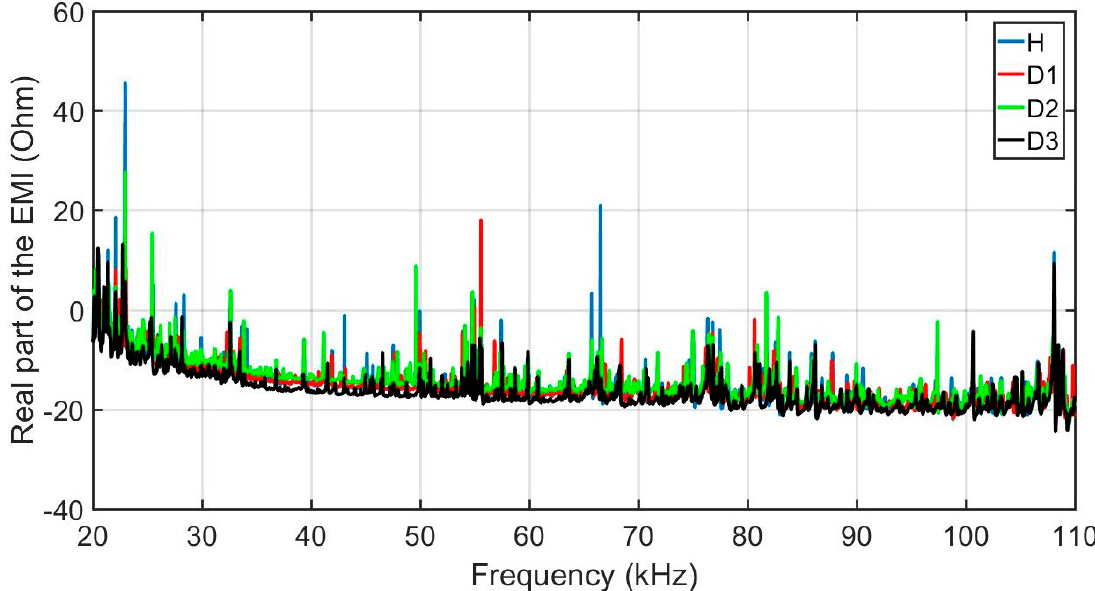
Figure 10. Real part of the EMI, for PZT#2, considering various structural conditions (H, D1, D2 and D3).